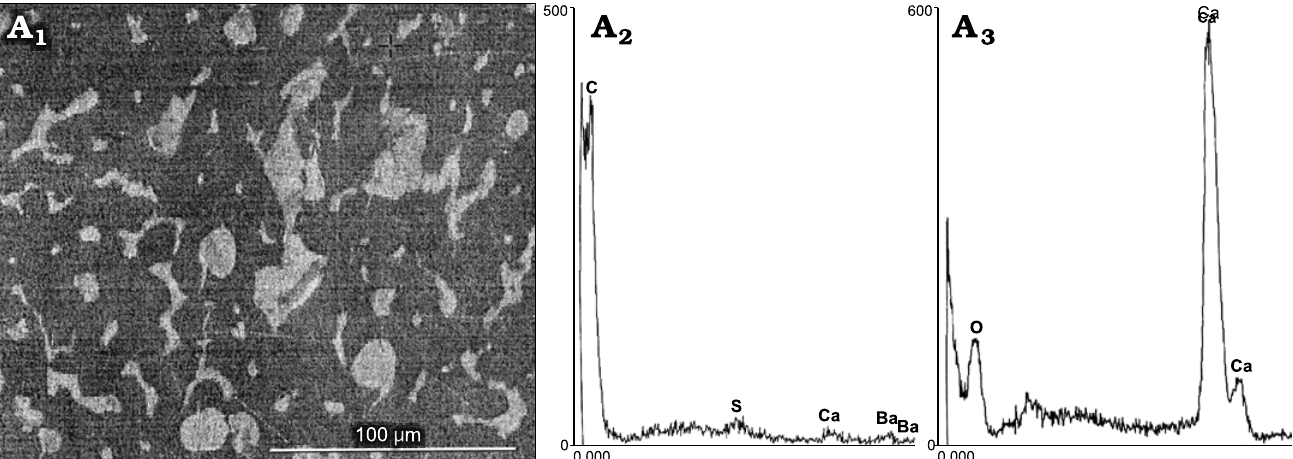
Fig. 6. Hypothesized “beak” of the coleoid cephalopod Phragmoteuthis bisinuata (Bronn, 1859) (GBW 2006/011/0009), lower Carnian, Upper Triassic, Cave del Predil, NE Italy. SEM/EDS data on ultrastructure and geochemical composition of the hypothesized “beak”. A 1 , a fracture of the “beak” showing a black structureless matrix containing whitish bone-like nanostructures; A 2 . high peak of C and lower peaks of S, Ca, and Ba, indicative a carbonized matrix (dark grey areas in A 1 ); A 3 , high peak of Ca, indicative a calcified material of nanostructures (whitish areas in A 1